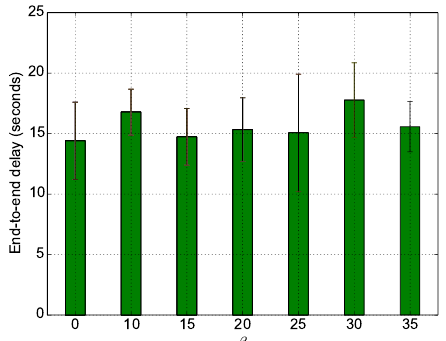
Figure 16. Average end to end delays per packet per data redundancy.